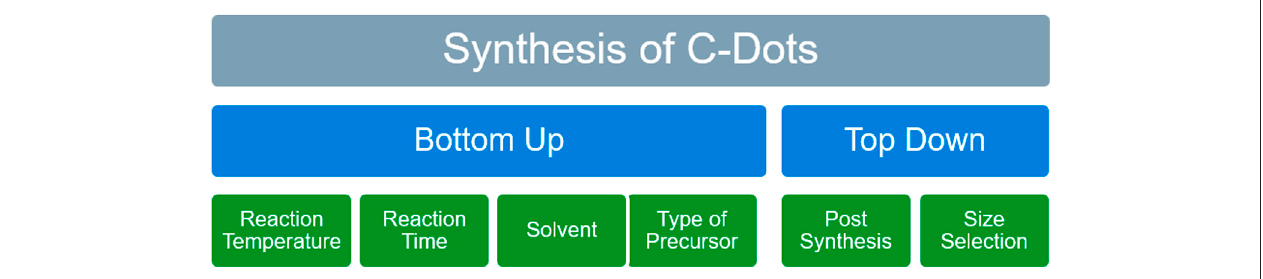
FIGURE 5 | Main synthesis route of C-Dots and the key factors affecting the design of C-Dots.